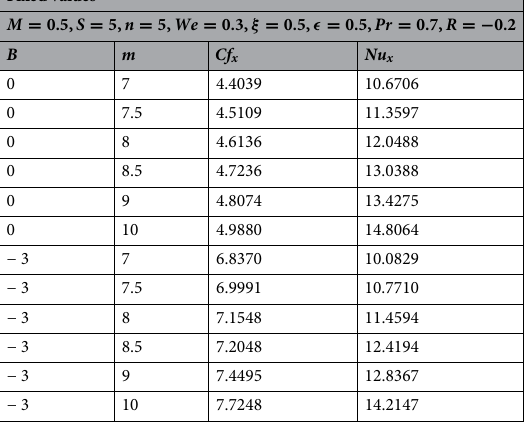
Figure 2. ( a ) Power law index effect on f Weissenberg number outcome on f